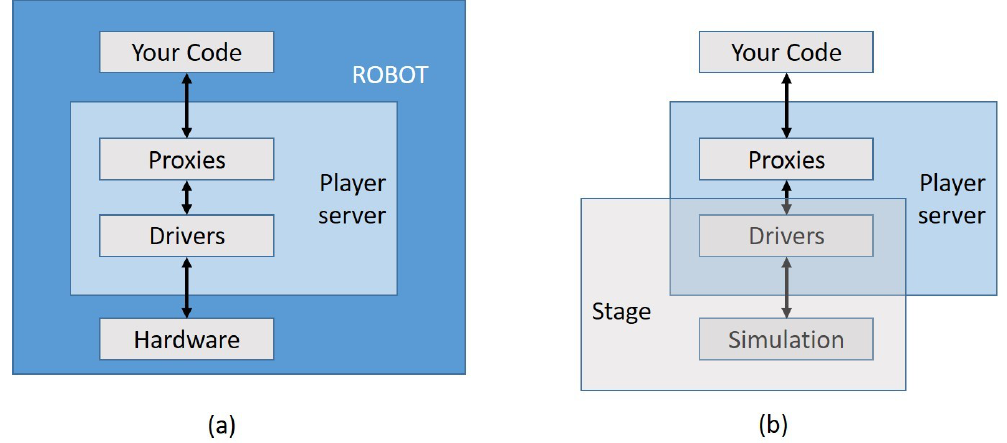
Figure 2. Player/Stage: connecting to: ( a ) a real robot; ( b ) a simulated